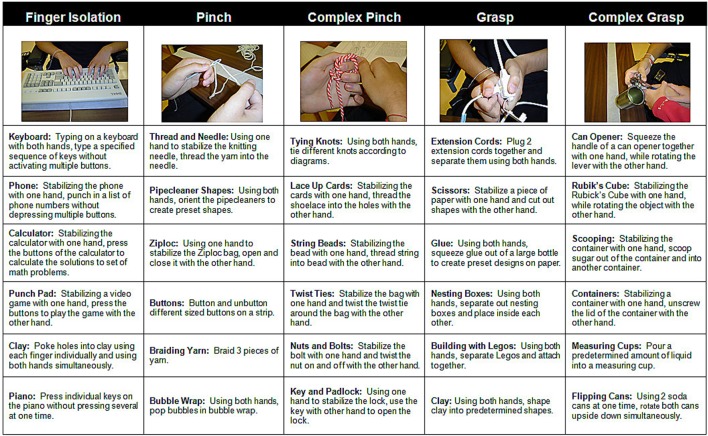
Sample bimanual functional task practice activities. Participants engaged in each category of activity for at least 20 min. The therapist provided verbal or tactile cues as needed to limit the use of compensatory strategies.